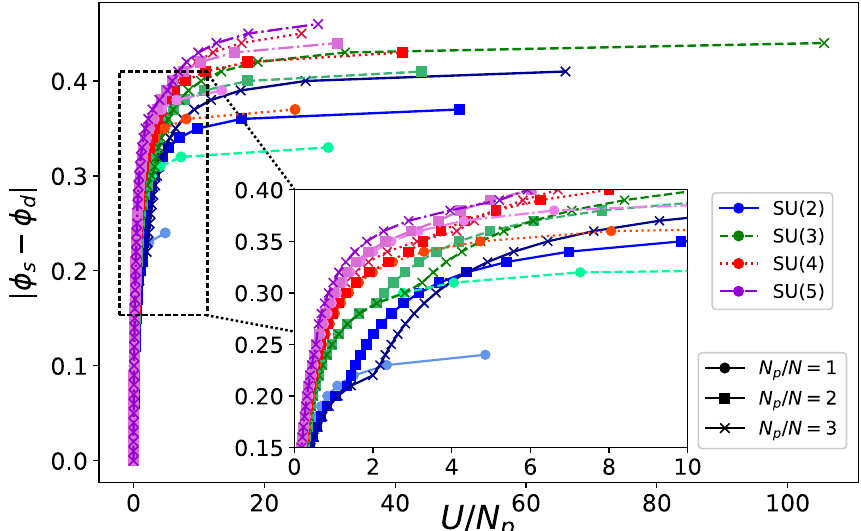
Figure 7: SU( N ) energy gap at integer filling. Minimal energy gap E for different N against U at comparable system sizes ( N = 2 and N = 4 with L = 8 and N = 3 with L = 9). All curves were obtained by exact diagonalization.